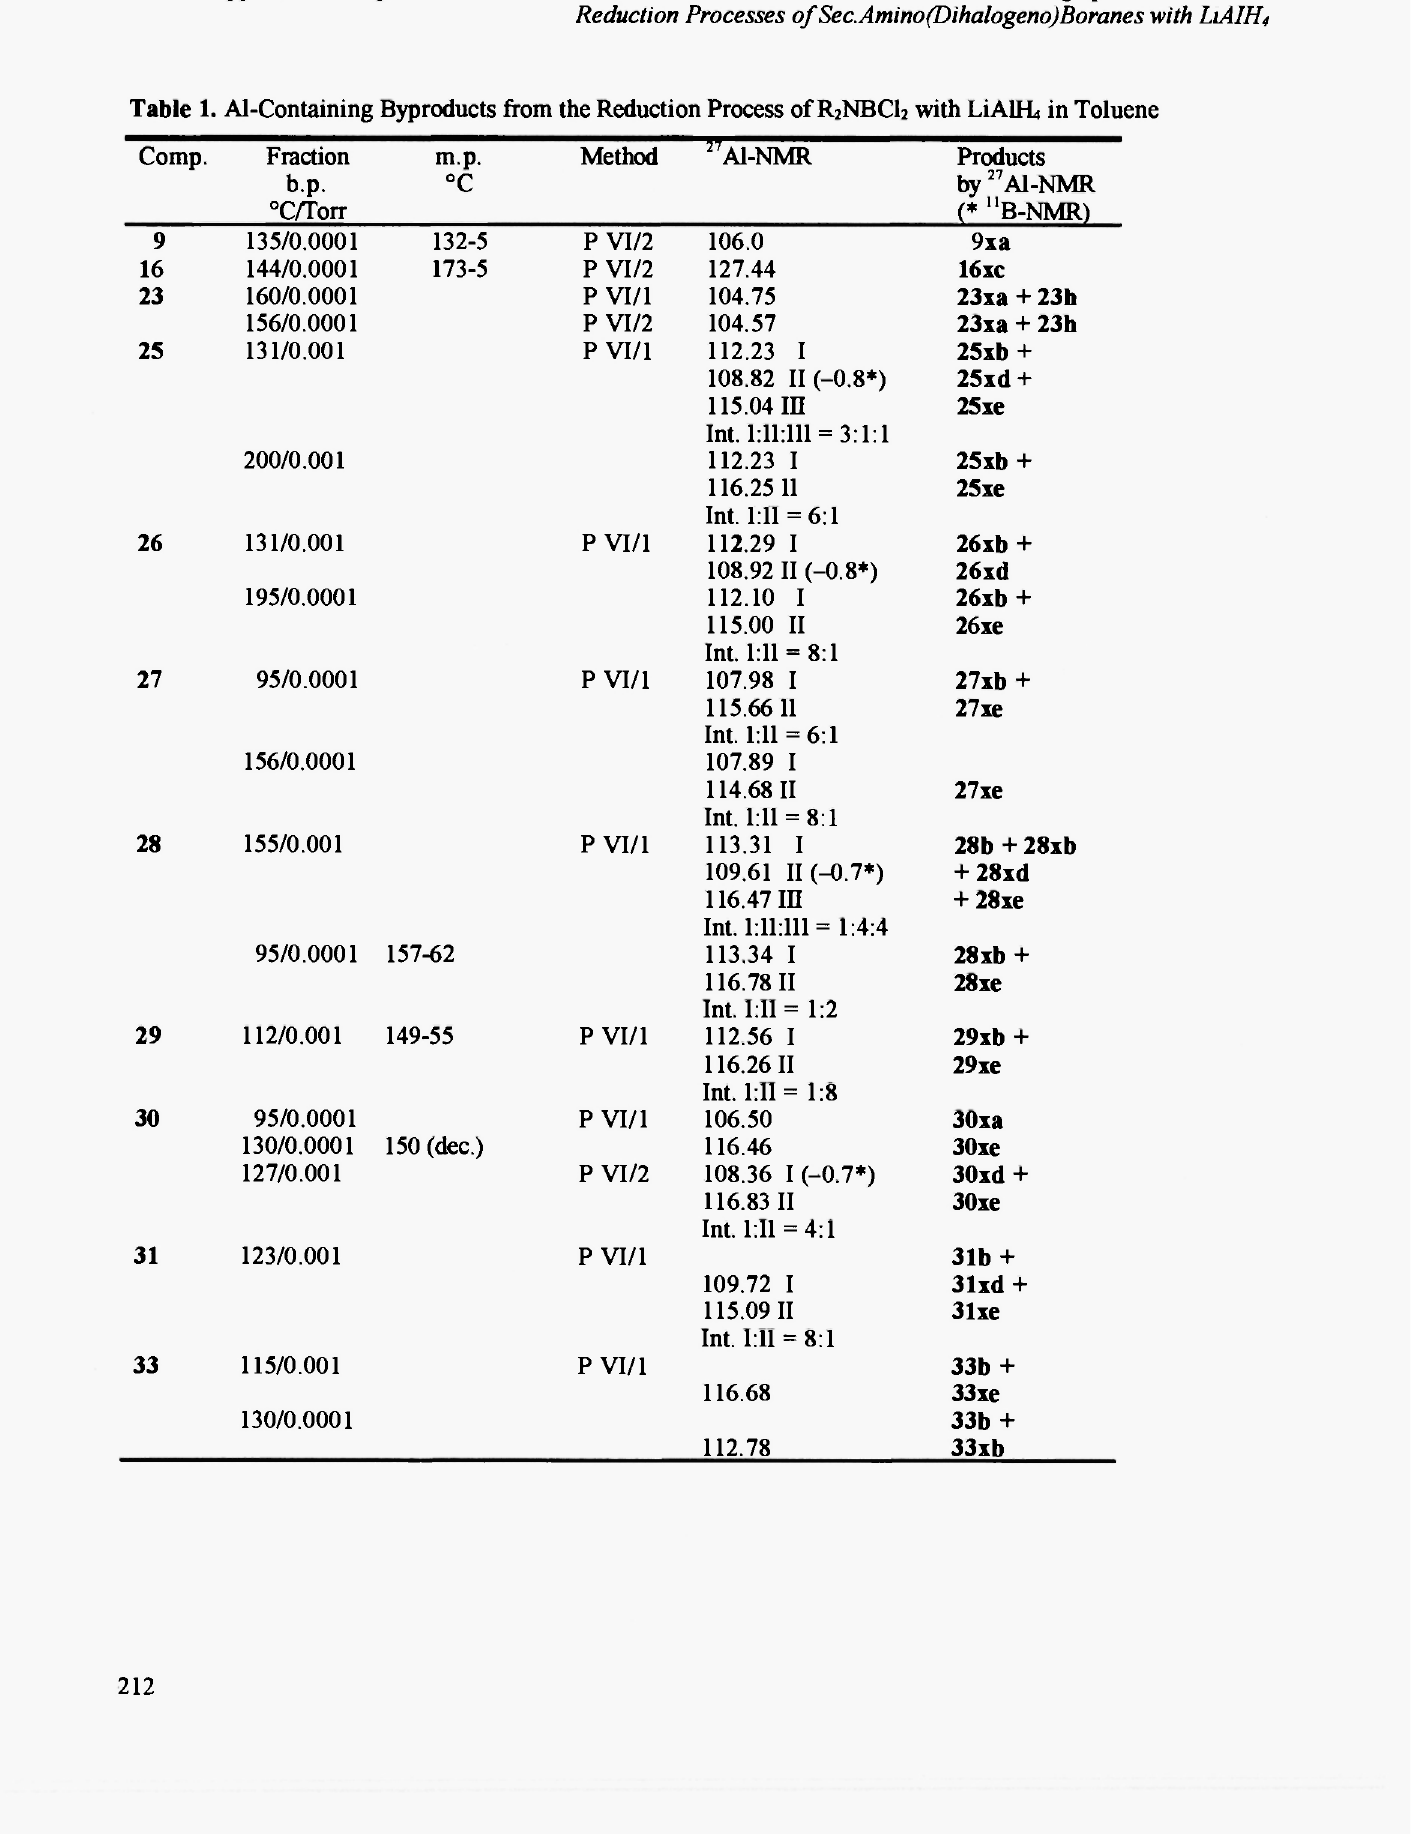
Table 1. Al-Containing Byproducts from the Reduction Process of R2NBCI2 with LiAU-L, in Toluene